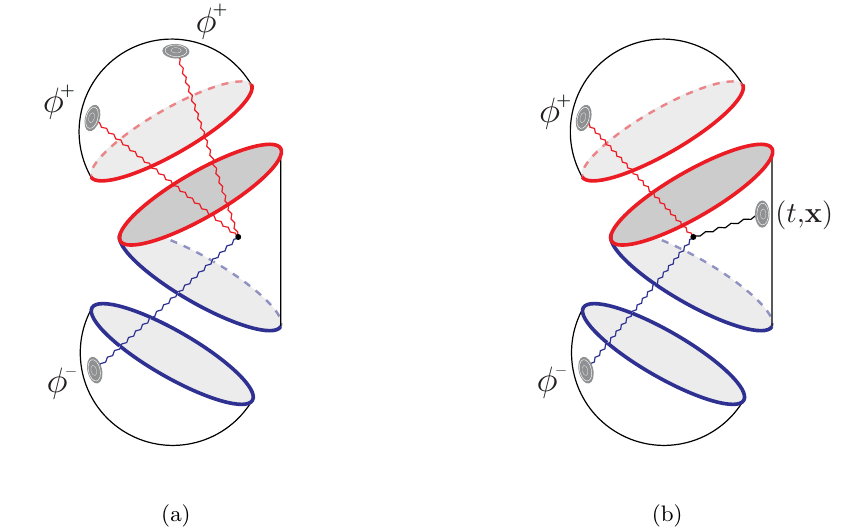
Figure 4 . (a) Example of a a diagram contributing to the inner product correction. The bulk and Euclidean sources insertion points are integrated over M and @ M (cid:6) respectively. The (cid:12)nal result is given by (4.16). (b) Example of a (cid:12)rst order correction diagram contributing to the 1-pt function. It is obtained from (4.14) by stripping away one Lorentzian source and removing its accompanying integral. The (cid:12)nal result for the (cid:12)rst order correction is given by (4.18).